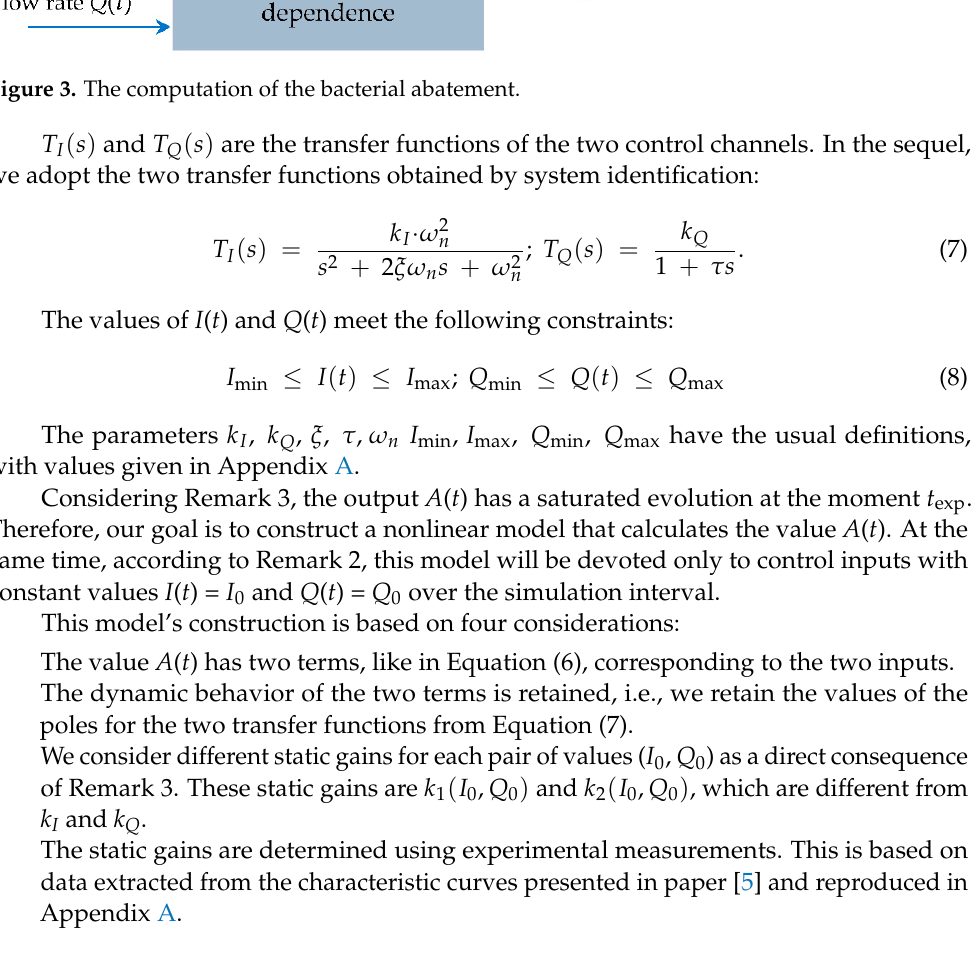
Table 1. Outline of function A ( I 0 , Q 0 , t ).